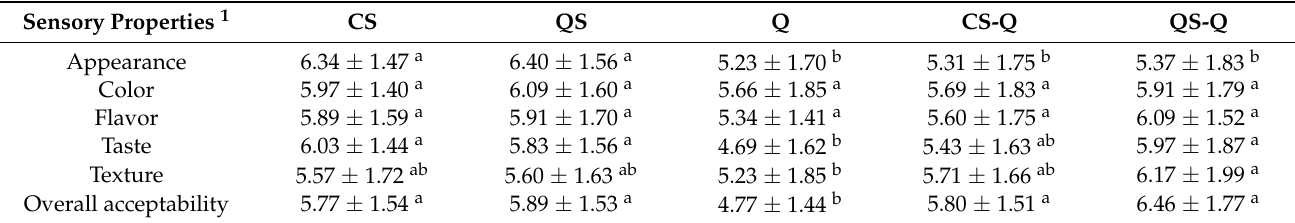
Table 5. Sensory scores of the chicken